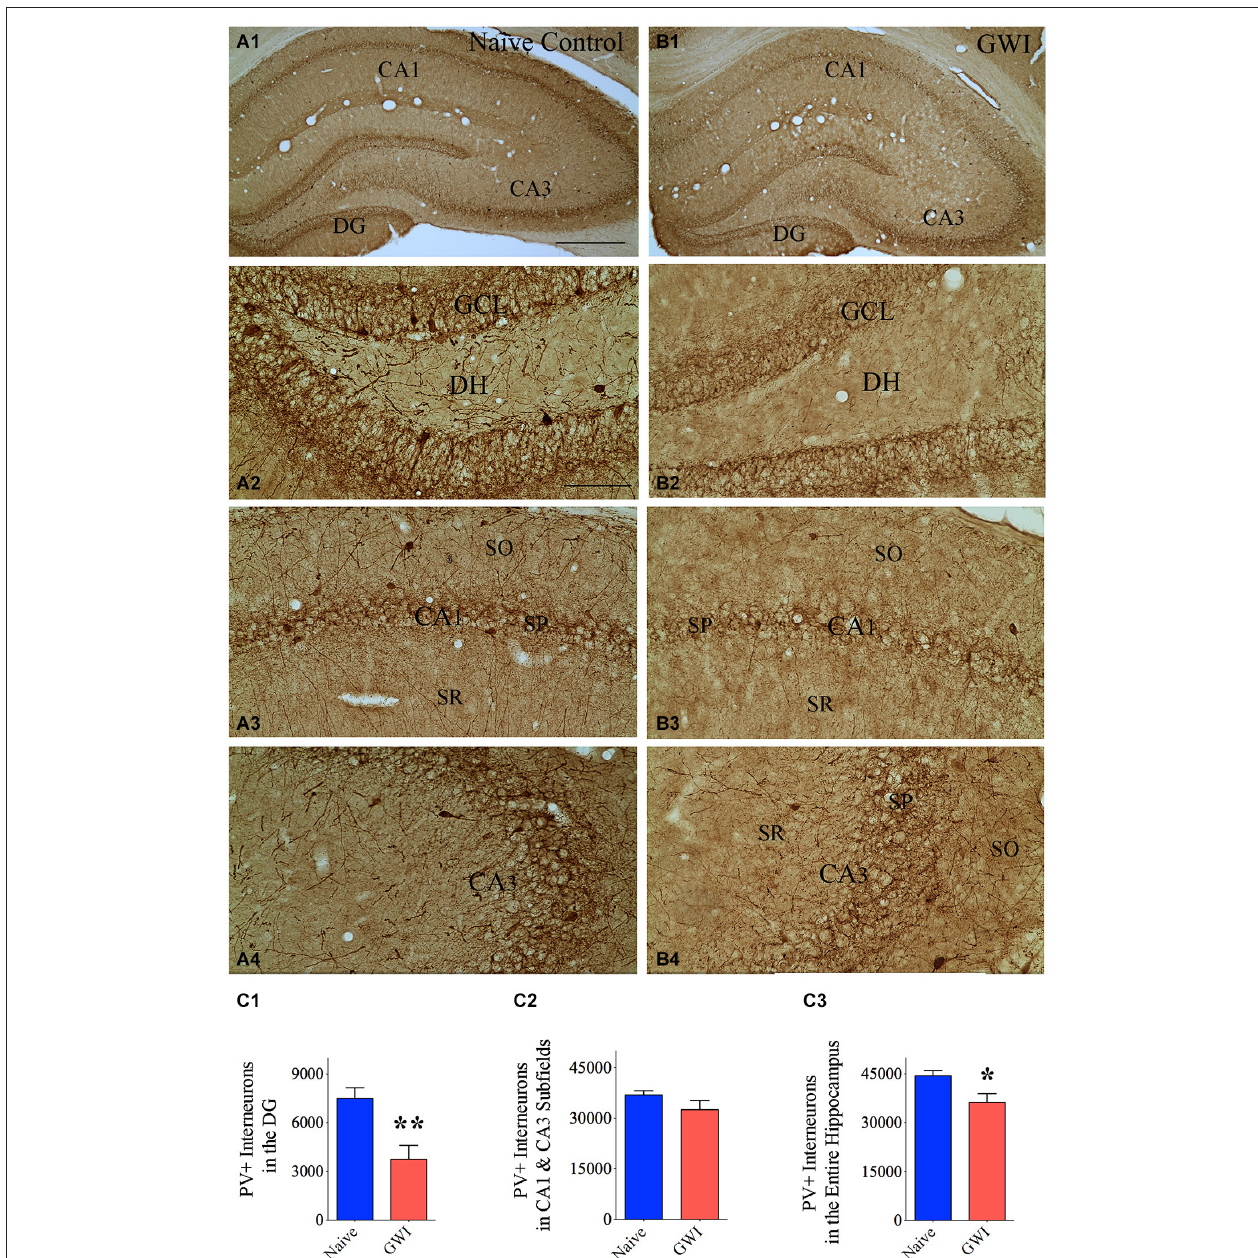
PV+ interneuron cell bodies and processes are seen in the DG and CA1 regions of a GWI-rat (B2, B3) , in comparison to respective regions from a naive control rat (A2, A3) . Scale bar (A1) and (B1) = 500 µ m; (A2–A4) and (B2–B4) = 100 µ m. Bar charts in (C1–C3) compare numbers of PV+ interneurons in the DG (C1) , CA1 and CA3 subfields (C2) and the entire hippocampus (C3) between naive control rats and GWI-rats. * p < 0.05; ** p < 0.01 (two tailed, unpaired Student’s t -test). DH, dentate hilus; GCL, granule cell layer; SO, stratum oriens, SP, stratum pyramidale; SR, stratum